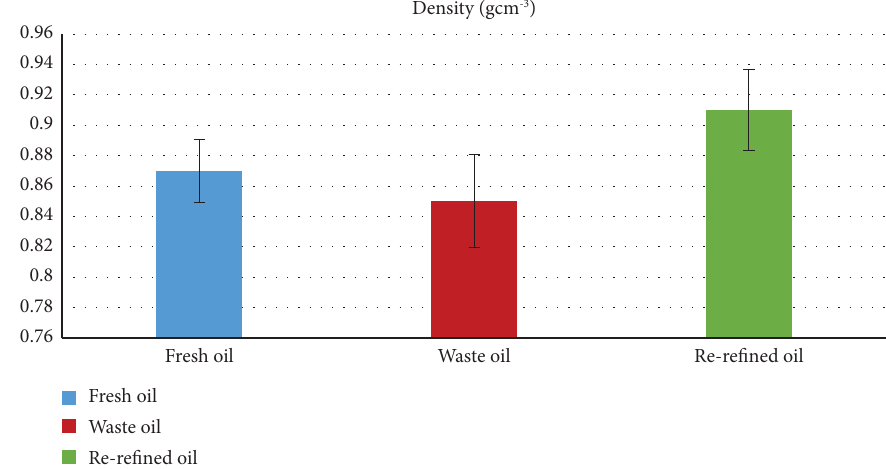
Figure 4: Density of oil